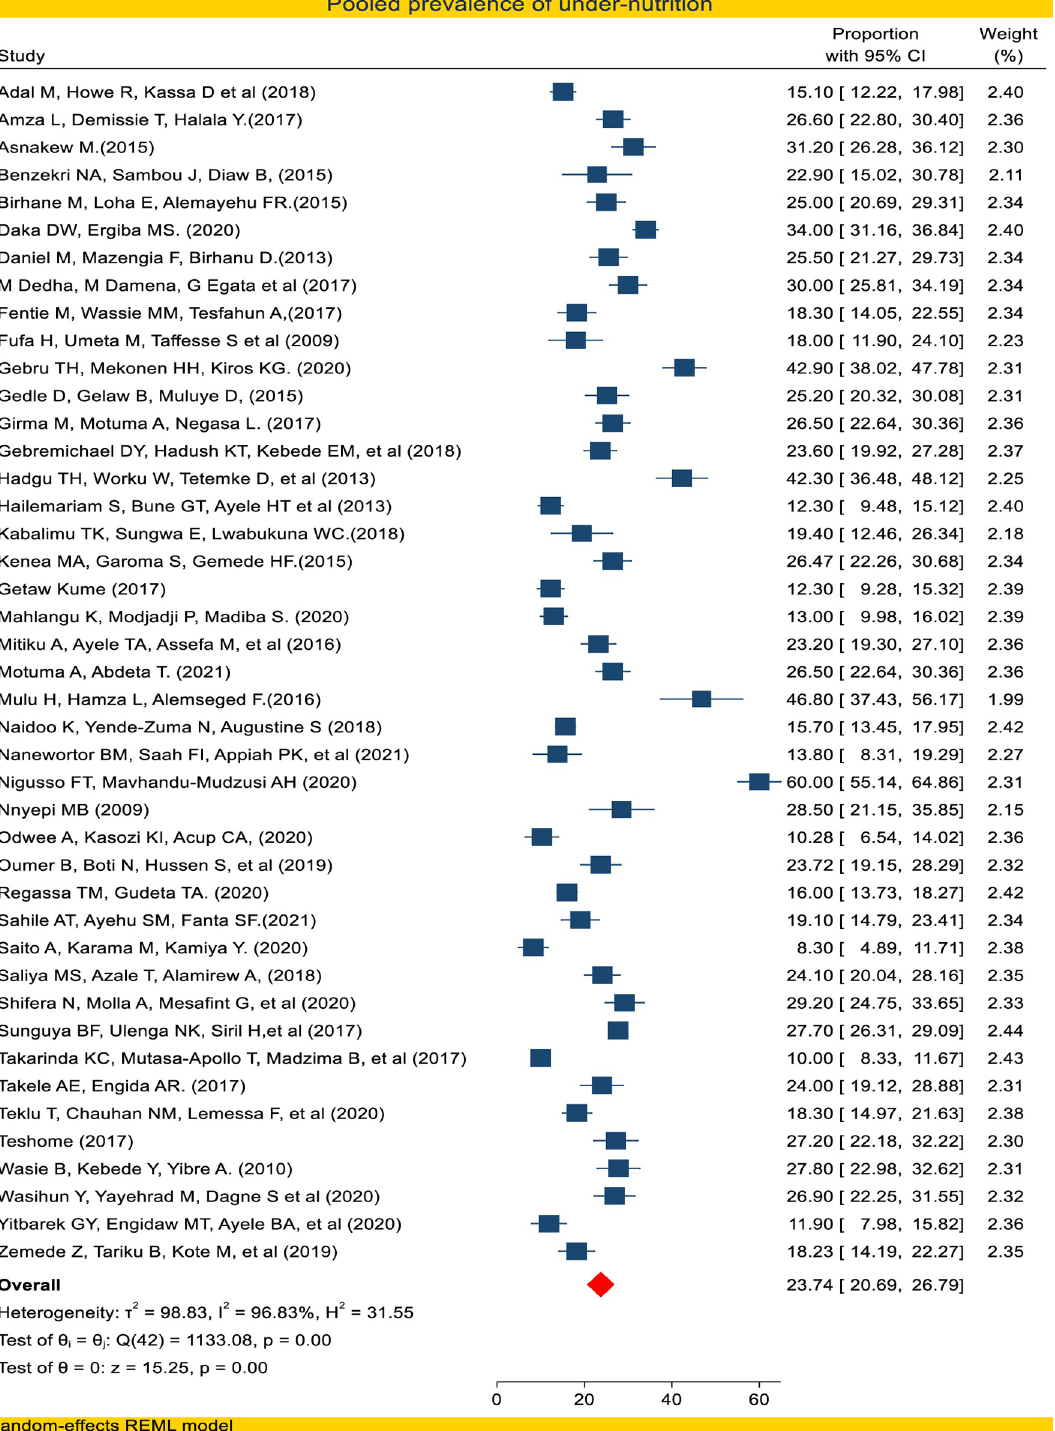
PLOS ONE | https://doi.org/10.1371/journal.pone.0283502 March 24,